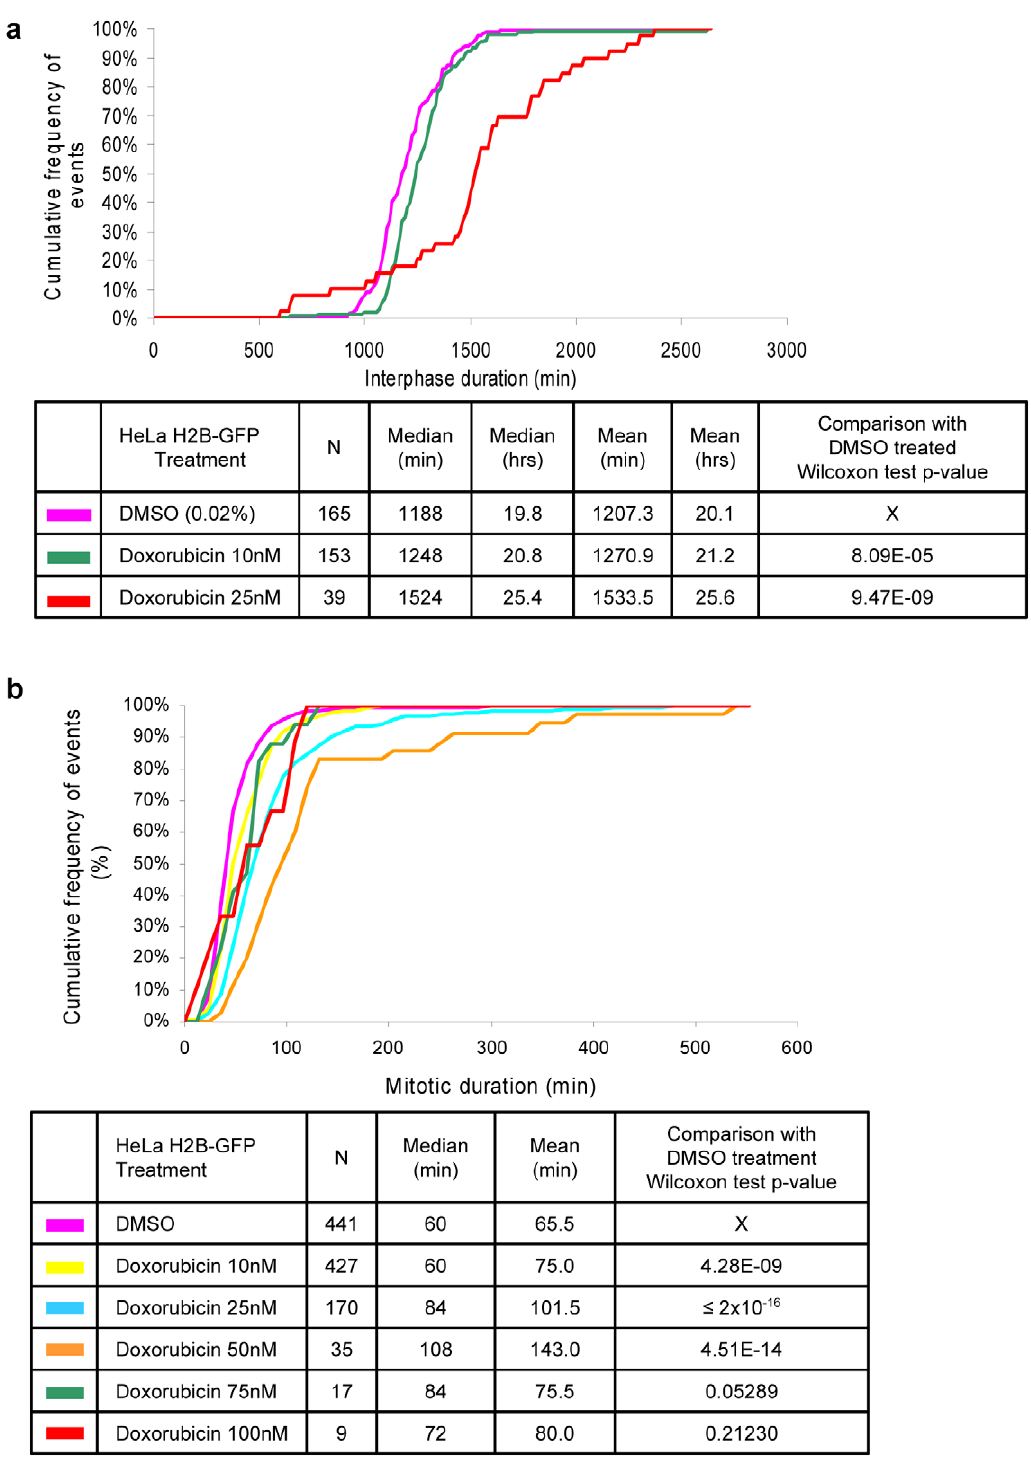
Figure 7. TSA detects changes in interphase duration in response to doxorubicin treatment. HeLa H2B-GFP cells were treated with doxorubicin at indicated concentrations. Cells were imaged every 12 min for 48 hours. For each condition, 4 fields in 2 independent wells were imaged and the results for the 8 image series were combined. Image series were analyzed using DC ELL IQ with TSA. Cumulative frequency curves of interphase (a) and mitotic (b) durations for the cell populations are